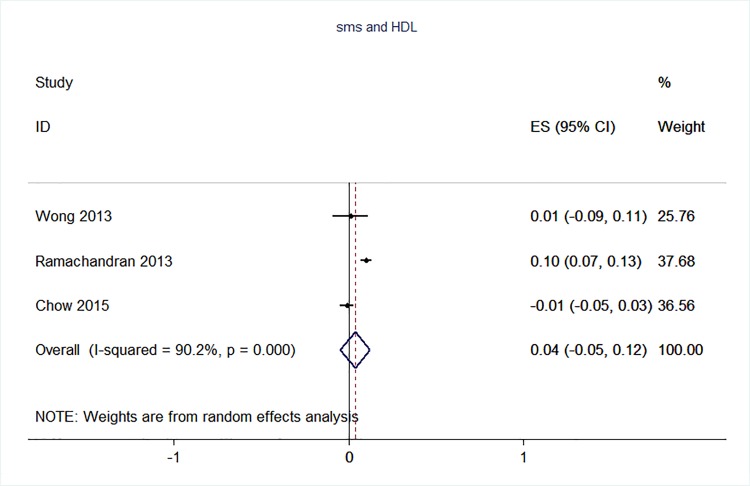
Physical activity and diet interventions using SMS function–high density lipoprotein cholesterol (mmol/L).